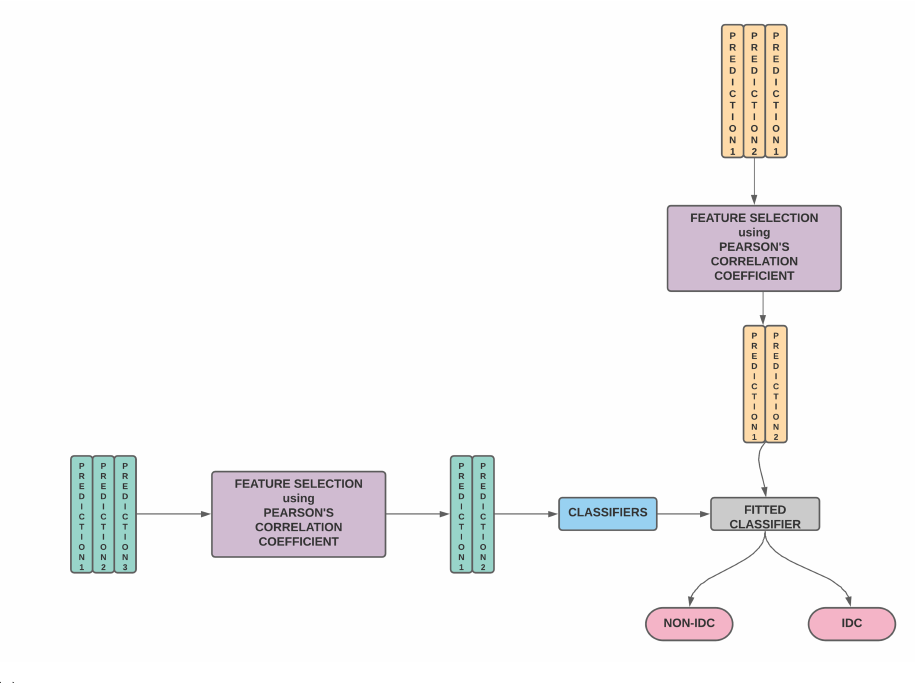
Figure 1. ( a ) The classifier is trained on the training set. The trained classifier is then used to predict the outcome of the validation set as well as the test set. ( b ) The second stage wherein the validation predictions for different classifiers are stacked to generate the new training features while the test predictions for different classifiers are stacked to generate the new test features. Using these new training and test features, the classifier is evaluated. ( c ) Our model wherein the second stage is modified and we perform feature selection on the new training and test features before model training and